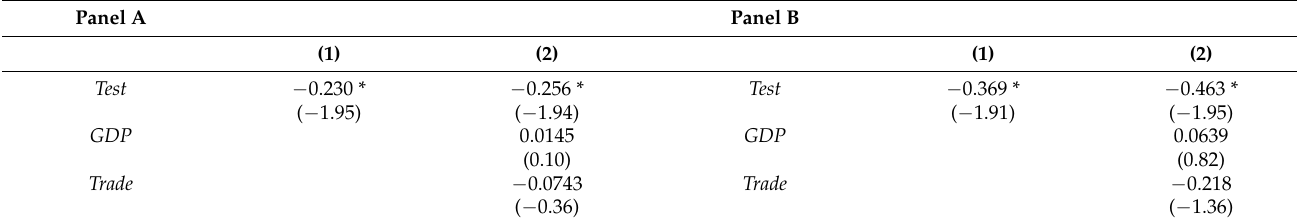
Table A7. This table shows the results of difference-in-difference test using an OLS regression. In Panel A the dependent variable is Diff ; the percentage change in the number of bids per year in each country 1 year before and after 1990. The main independent variable is Test , an indicator variable that equals 1 if a country falls in the test sample. Macro-economic control variables have been included in all model 2. Panels B, C, and D shows the results of the same test performed with 1991, 1992, 1993 as the reference years,